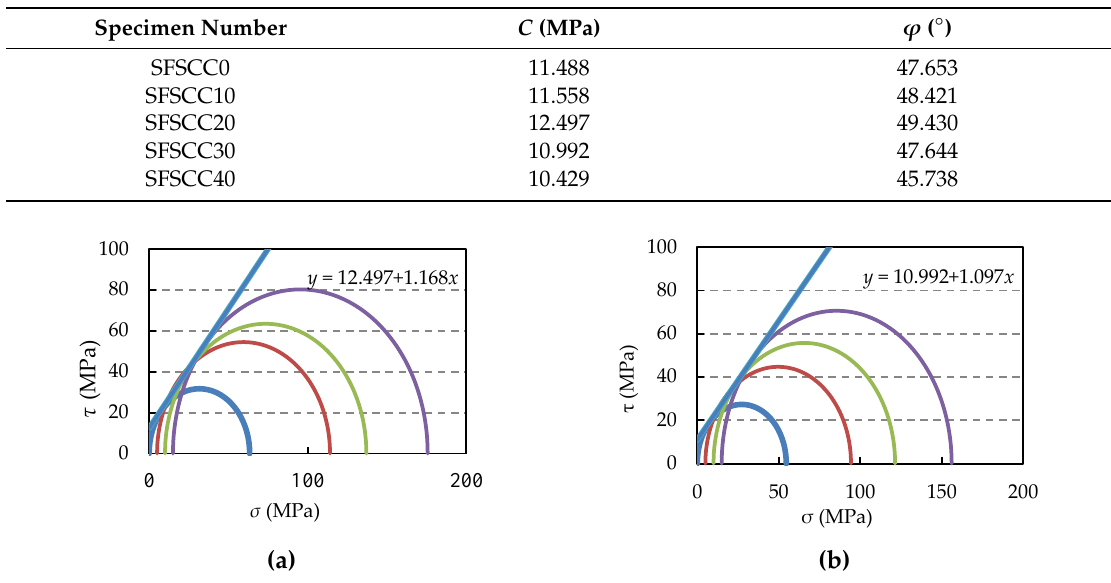
Table 10. Mohr-Coulomb parameters of SCC with FA with SF.